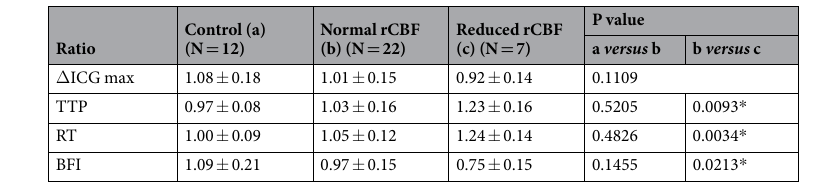
Table 2. rCBF and measured values of parameters by NIRS/ICG. Ratio is given as affected side to non- affected side ratio. Values are given as mean ± standard deviation. * A P value < 0.05 was defined as statistically significant. BFI, blood flow index; ICG, indocyanine green; NIRS, near-infrared spectroscopy; rCBF, regional cerebral blood flow; RT, rise time; TTP, time to peak.